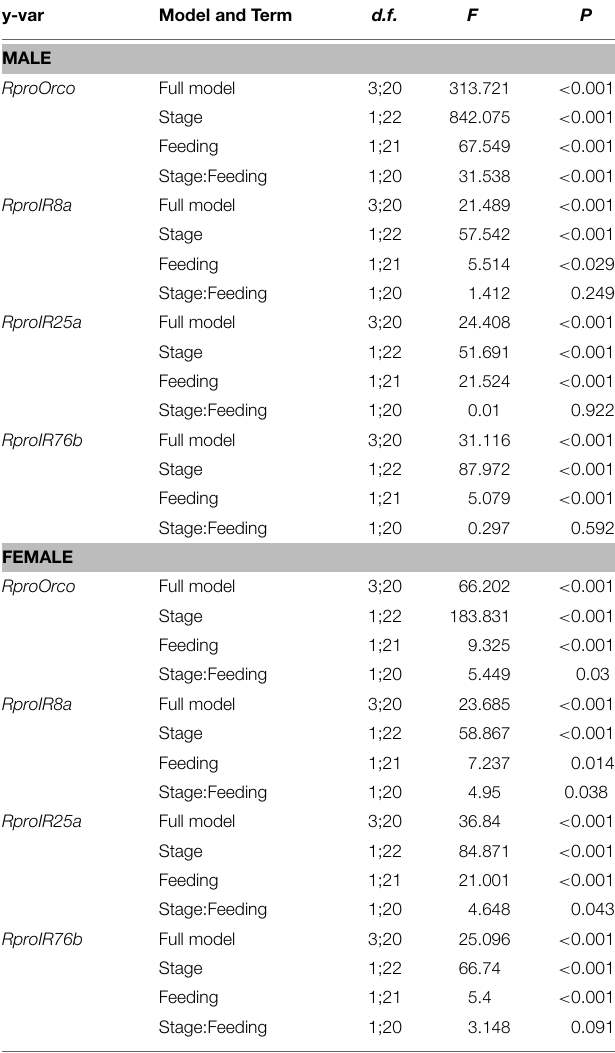
TABLE 3 | Generalized Linear Modeling for olfactory coreceptor gene expression in male and female antennae of Rhodnius prolixus . y-var Model and